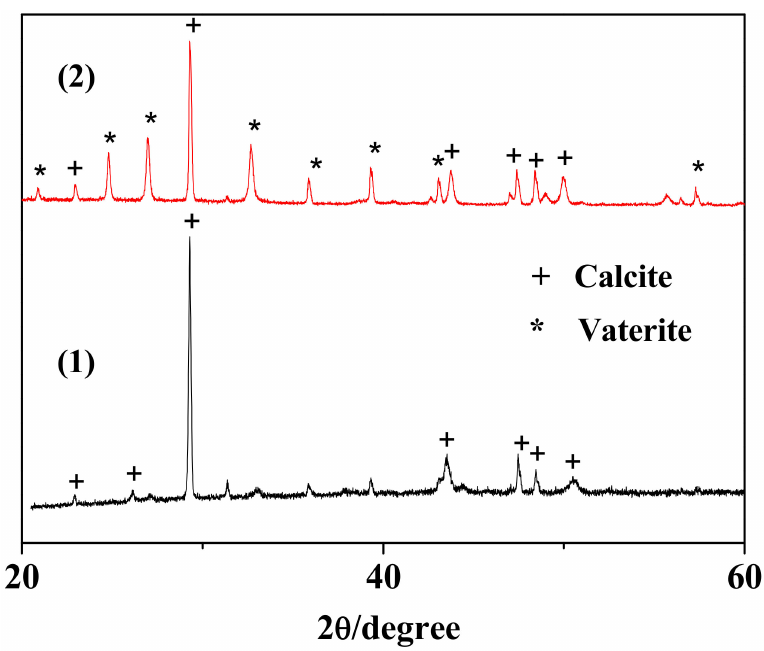
Figure 3. XRD pattern of CaCO 3 crystals in the scaling solution: ( 1 ) blank; ( 2 ) containing 8 mg / L PBTCA.